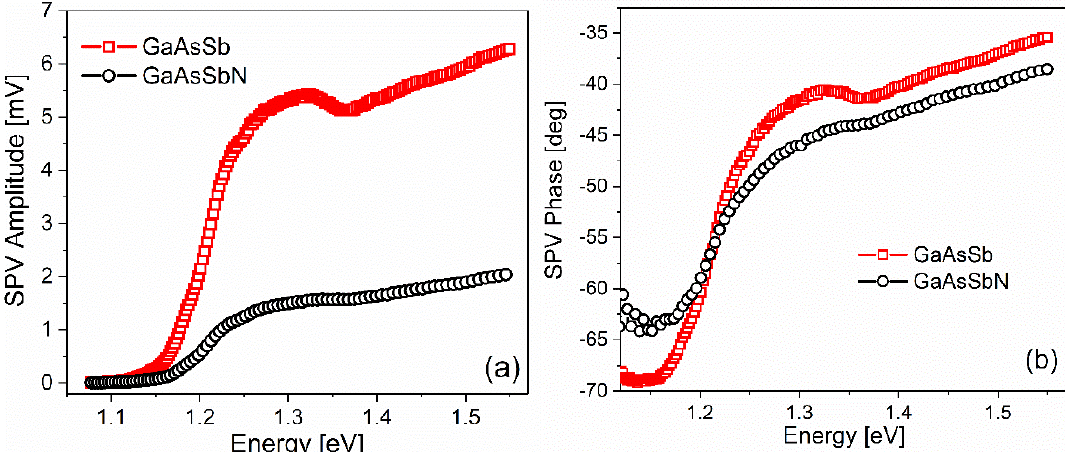
Figure 3. Surface photovoltage amplitude ( a ) and phase ( b ) spectra of GaAsSbN/GaAs (black circles) and GaAsSb/GaAs (red squares) structures.